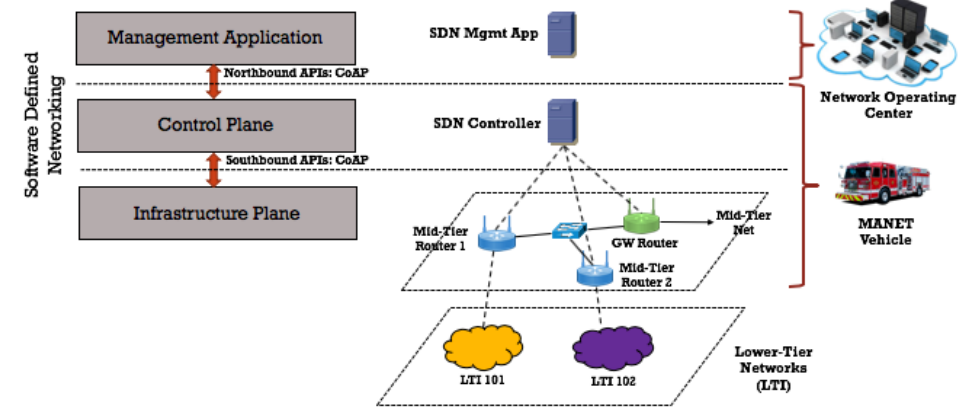
Figure 1. SDN Architecture of Heterogeneous